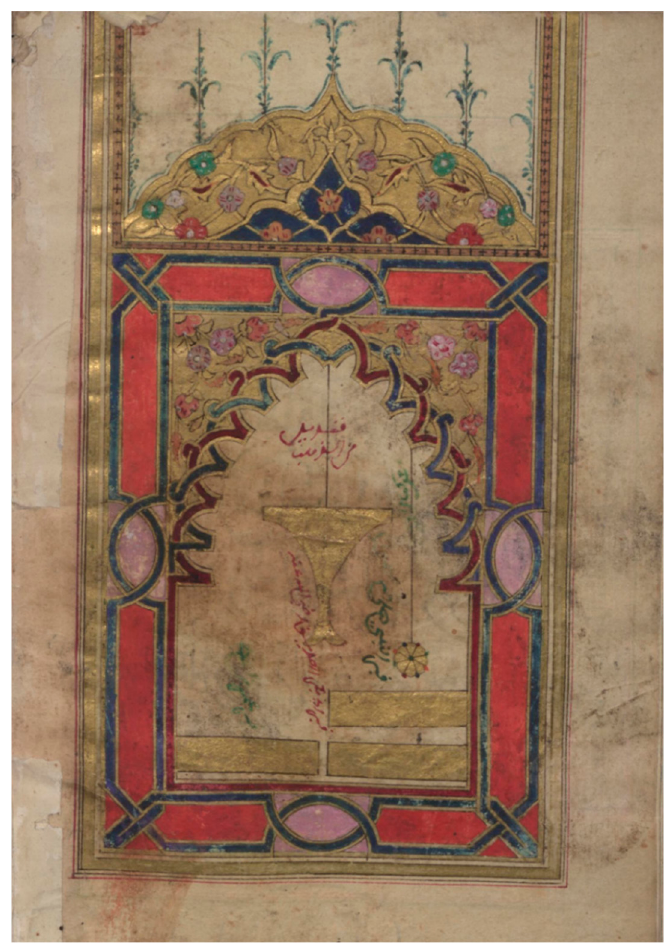
Figure 11. A probably eighteenth century depiction of the Raw ḍ a , from a Maghribi manuscript copy of the Dal ā ’il , demonstrating the highly schematized style that remained popular in North Africa—here reduced to almost pure geometric abstraction—alongside evidence of extensive tactile veneration, all contained within a framing that combines long-standing Maghribi motifs with a headpiece and floral fill highly typical of Ottoman manuscript illumination. University Library of Leipzig, Cod. Arab. 114.